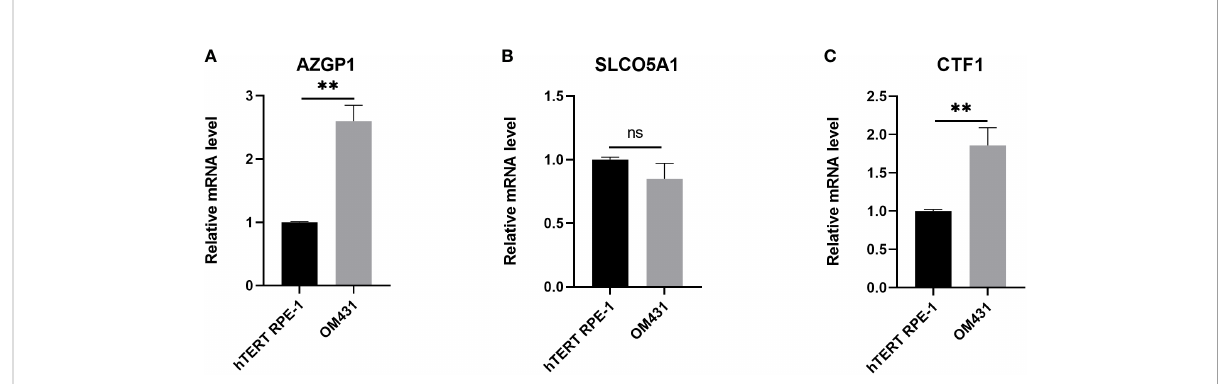
FIGURE 6 Veri fi cation of the expression of the three core genes in cells (A – C) The expression of AZGP1, SLCO5A1, and CTF1 in Human retinal pigment epithelial cell line(hTERT RPE-1) and uveal melanoma cells (OM431) was detected by RT-qPCR, cellular experiments were performed in three independent replicates, data in the fi gures are all measures in the form of mean ± standard deviation, data were analyzed by t-test,** indicates p <